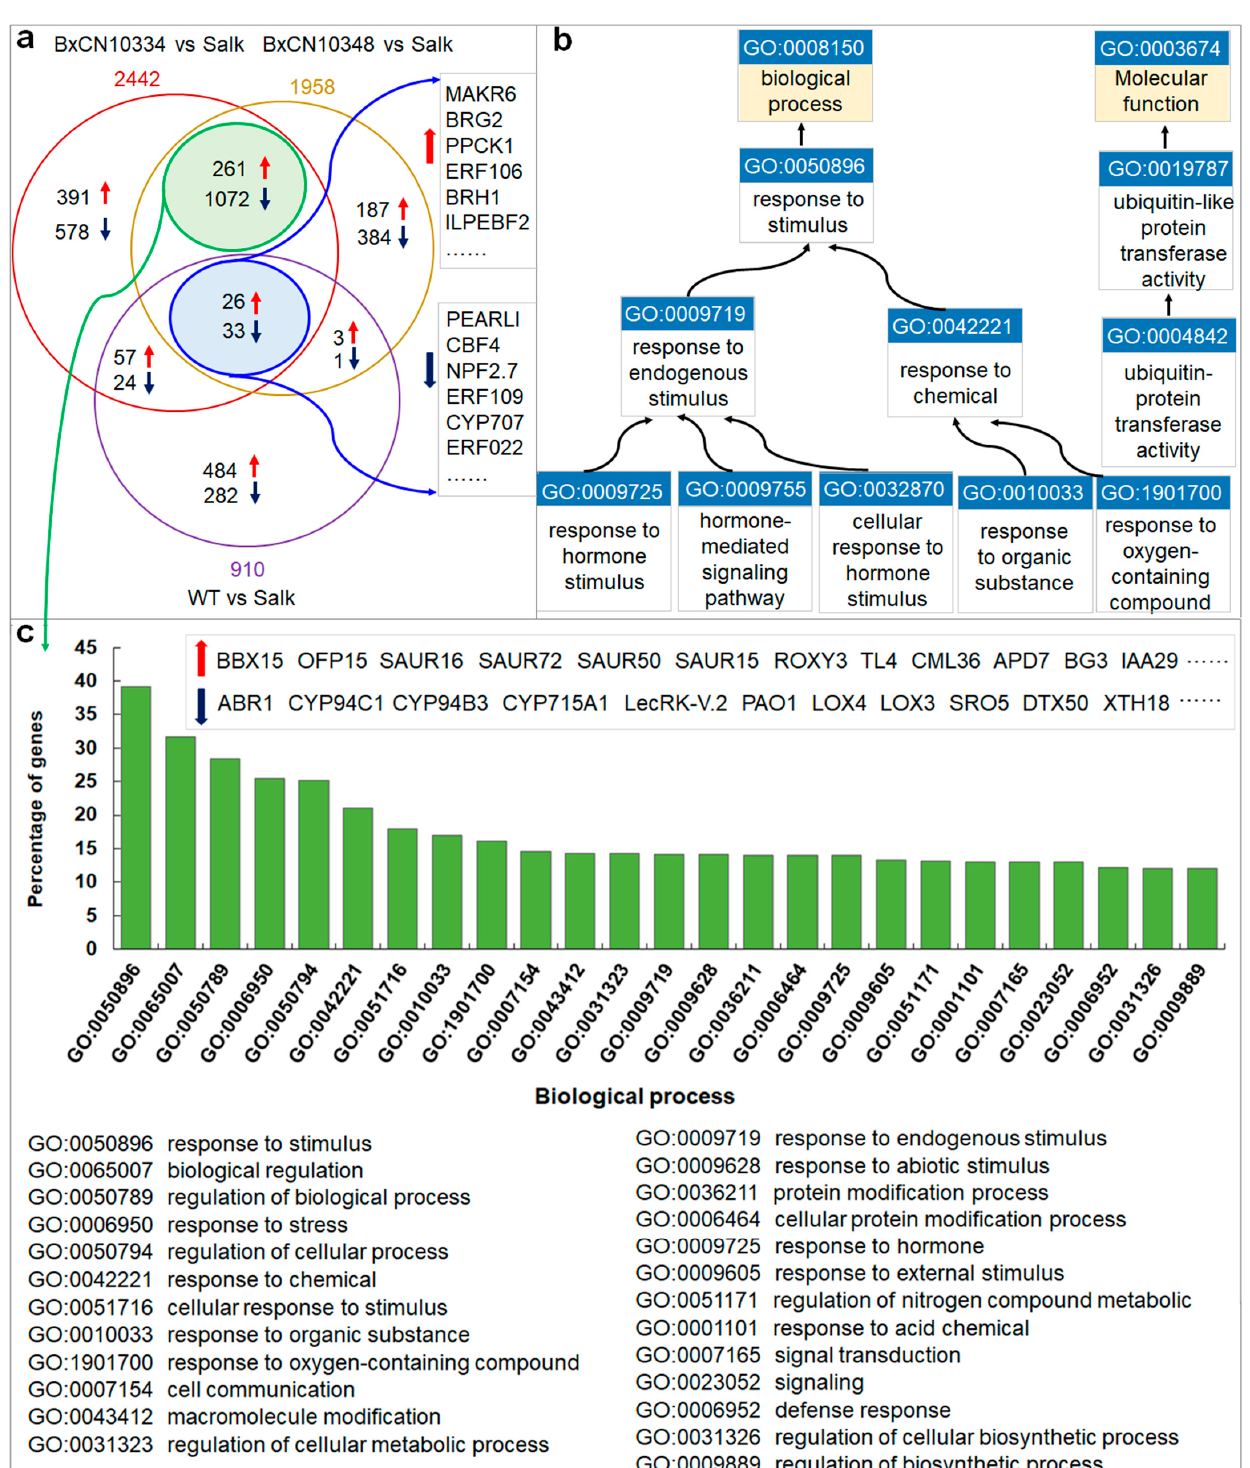
Figure 7. Differentially expressed genes (DEGs) in the four types of Arabidopsis transcriptomes and enrichment in GO terms: ( a ) Venn diagram shows common and specific DEGs among the transcriptomes of the wild-type and the two transgenic lines introduced with B. xylophilus -specific legumain-coding genes (BxCN10334 and BxCN10337), each compared with the control ( ∆ γ vpe mutant); ( b ) enriched GO terms of the 59 common DEGs, which with identical expression patterns among the above three transcriptomes; ( c ) the top enriched GO terms of additional 1333 DEGs, which have identical expression patterns between the two transgenic lines